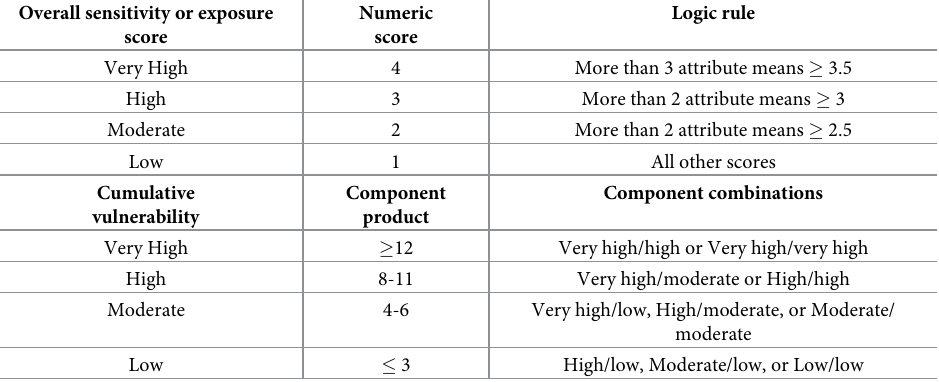
Table 3. Logic rule for ranking sensitivity and exposure components and cumulative vulnerability. We used the logic rule across attributes to assign a numeric score and vulnerability category to sensitivity and exposure components (top section). We then used the product of the numeric component scores to assign cumulative vulnerability for each DPS (bottom section). Overall sensitivity or exposure